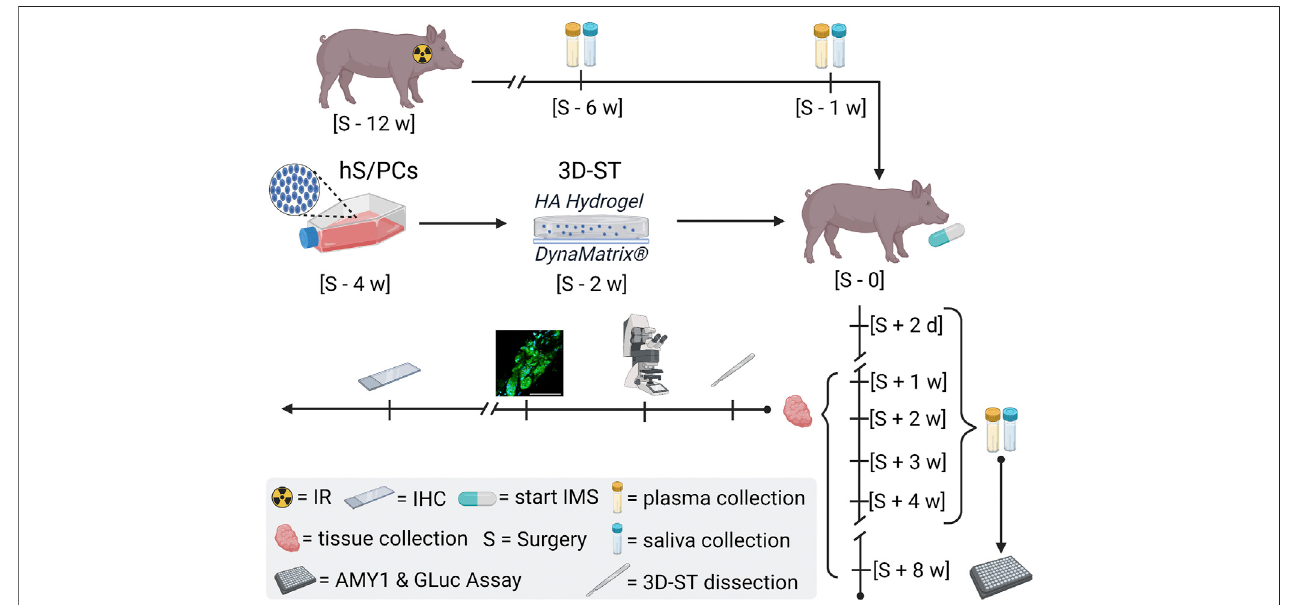
FIGURE 7 | General schematic of the miniswine implant model. Irradiation (IR) of the minipig is scheduled 90 days ∼ [S — 12 w] before the day of surgery [S — 0] to induce hyposalivation. Saliva and plasma samples are collected post-IR [S — 6 w] and [S — 1] to assess IR-induced hyposalivation and to establish miniswine-speci fi c baselines.TheencapsulationofhS/PCsinimplantable3D-STsistimedfor2 weekspriortosurgery[S — 2w]toensurecellgrowthandstabilitypriortoshipment.The3D- STs are shipped to Pittsburgh for implantation into the irradiated minipigs. Immunosuppression (IMS) regimens started on the day of surgery [S — 0] as well as continuous care and oversight provided by the Allegheny General Hospital veterinary team. Saliva and plasma samples are also collected 2 days post-surgery [S + 2 days] and weekly [S + n w] for downstream human AMY1 and GLuc analysis. Tissue is harvested at terminal timepoints and shipped to Houston on wet ice for 3D-ST dissection and for control-tissue resections for L/D and IHC